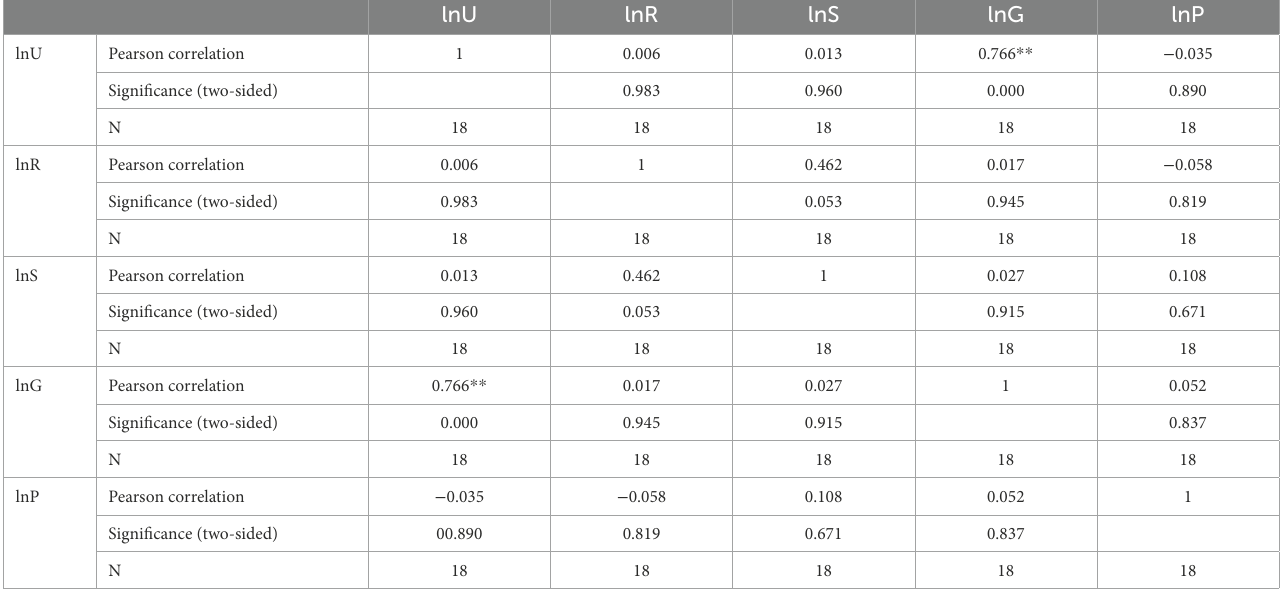
** Significantly correlated at the 0.01 level (two-sided). The correlation analysis reveals that U and G are significantly correlated.